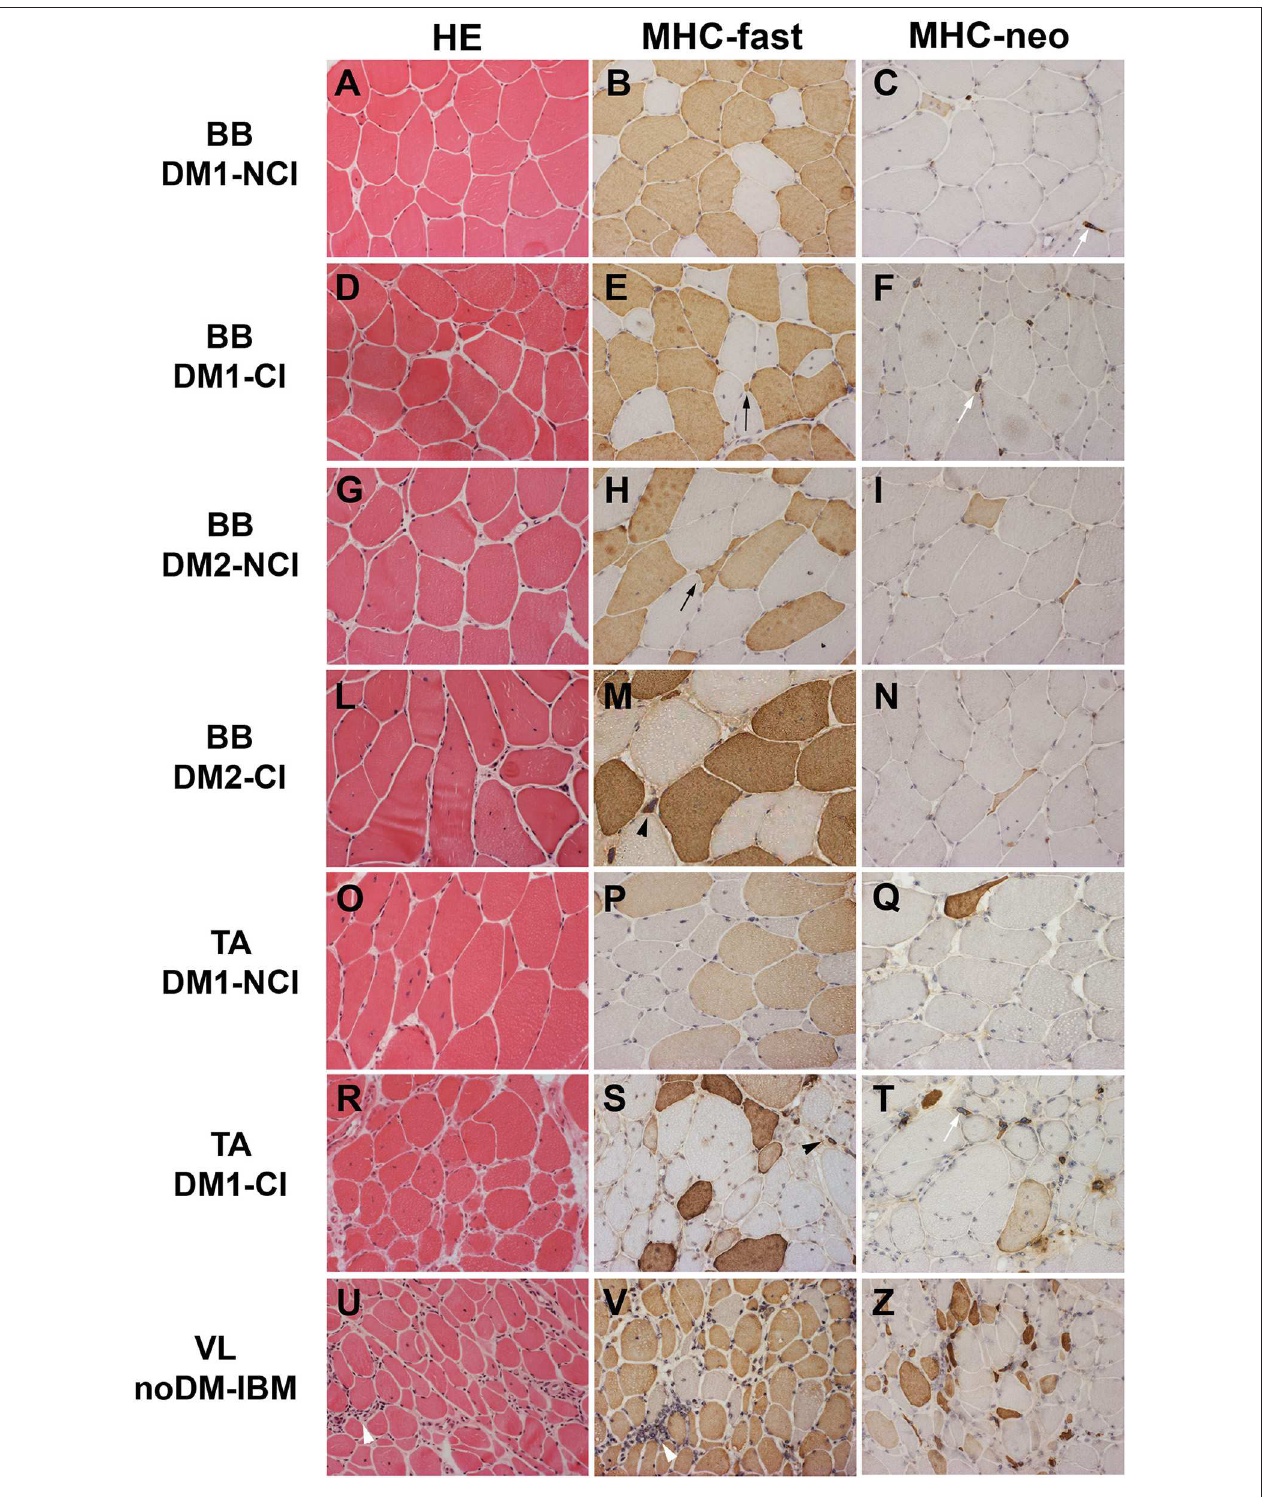
FIGURE 1 | Hematoxylin and eosin (HE) staining and immunostaining of fast myosin heavy chain (MHC-fast) and neonatal myosin heavy chain (MHC-neo) of representative DM1 (A–F) and DM2 (G–N) biceps brachii (BB), DM1 tibialis anterior (TA) (O–T) , and noDM-IBM (U–Z) vastus lateralis (VL). DM1 and DM2 patient groups have been divided into two subgroups according to the presence of cardiac abnormalities: NCI, no cardiac involvement; CI, cardiac involvement. Patient group